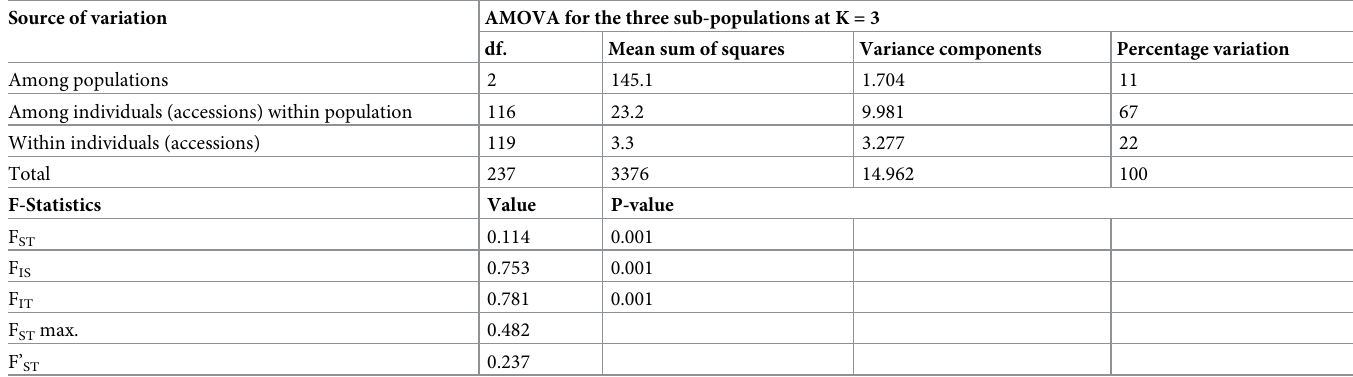
Table 2. Analysis of molecular variance (AMOVA) of the sub-populations of panel population at K = 3 for Fe-toxicity tolerance in rice of 119 genotypes.